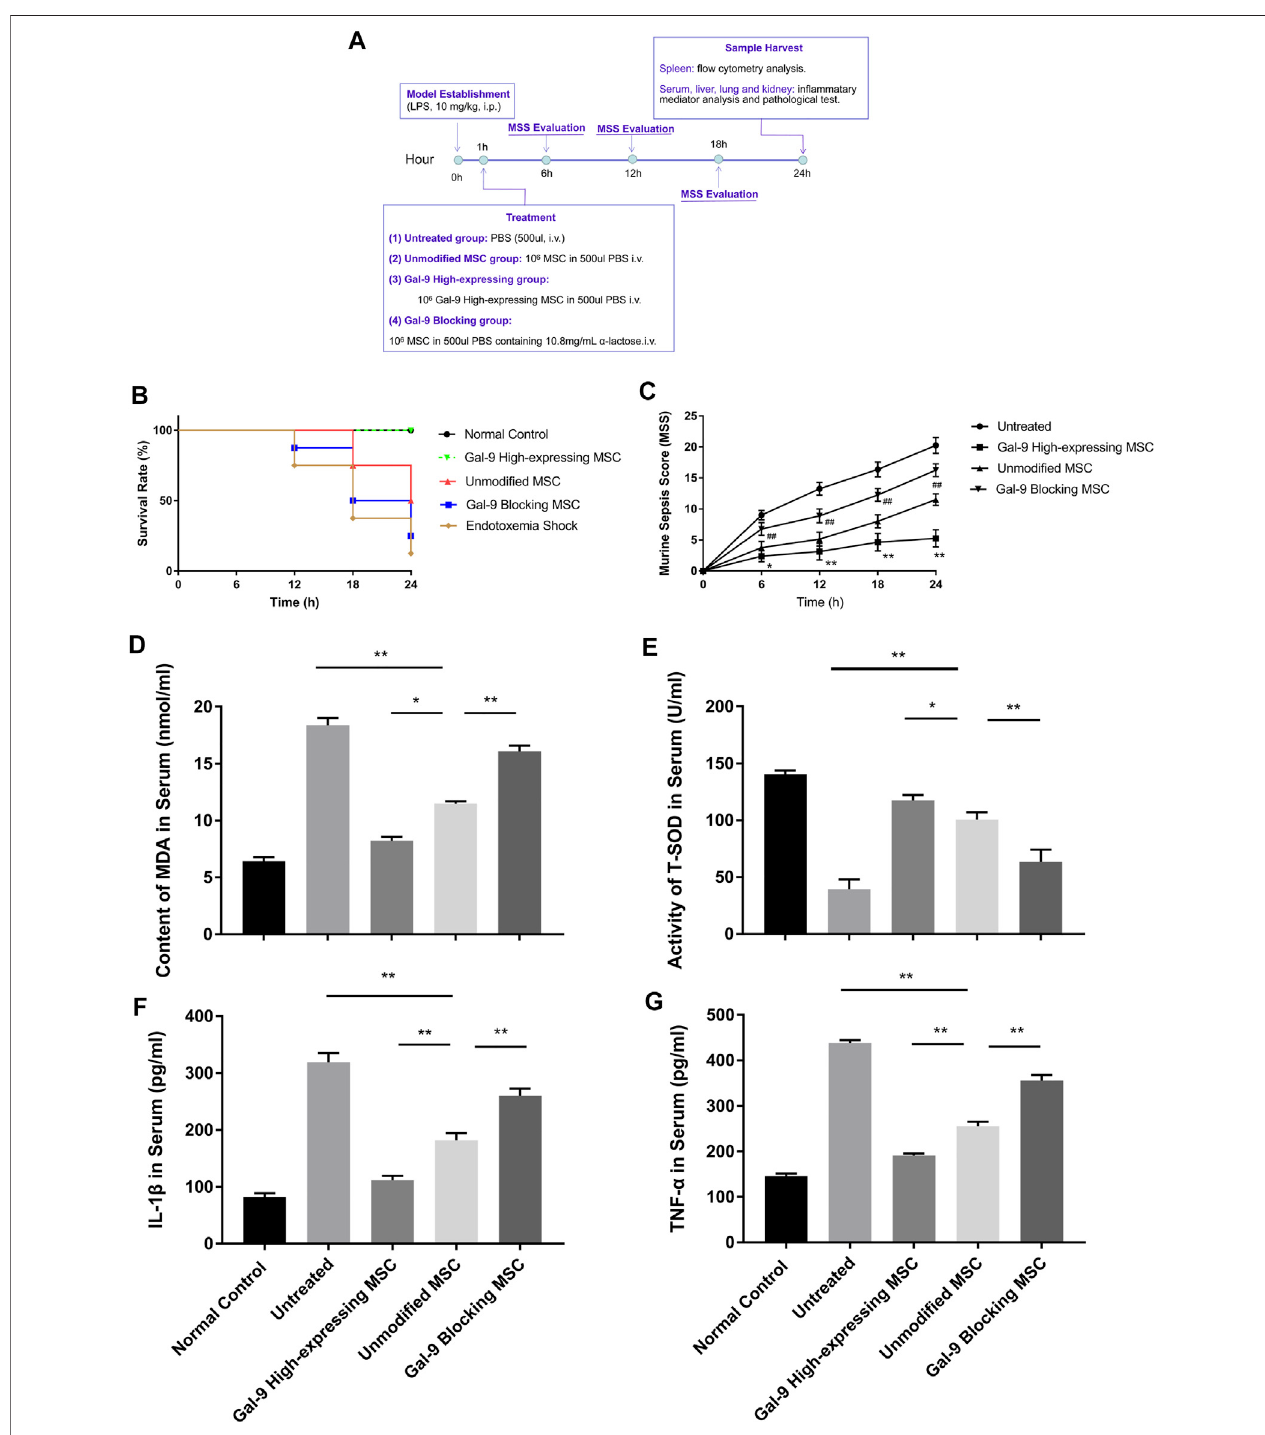
FIGURE2| Gal-9 mediates MSC-based therapyin alleviating symptoms and in fl ammatory mediators ’ expression. (A) Time schedule ofthiswholeexperiment. (B) Endotoxemia mice survival rate, n = 8. (C) Mean murine sepsis score (MSS) in different groups ( n = 8, * p < 0.05, ** p < 0.01, # p < 0.05, and ## p < 0.01). (D – E) MDA and T-SOD expression level in serum, n =6. (F – G) IL-1 β and TNF- α secretions in serum, n =6. Data variance wasassessed by using one-way analysis ofvariance (ANOVA), followed by least signi fi cant difference (LSD) test. * p < 0.05, ** p < 0.01. Abbreviations: MDA, malondialdehyde; T-SOD, total superoxide dismutase.